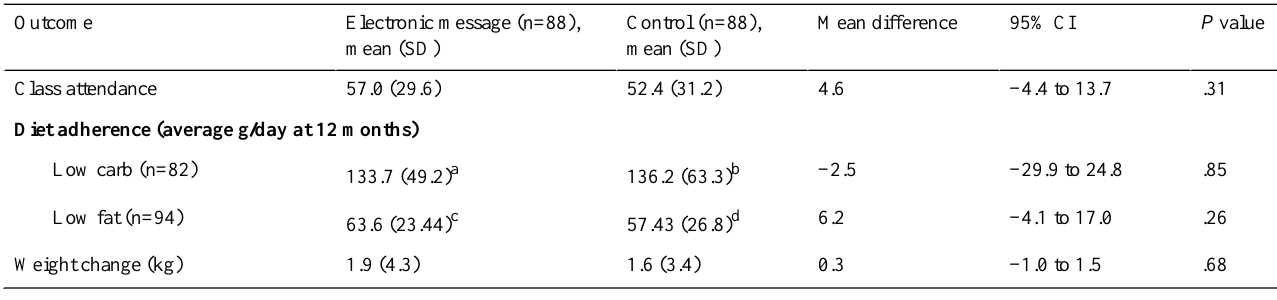
Table 2. Estimated means and mean difference per outcome in the electronic message group versus the control